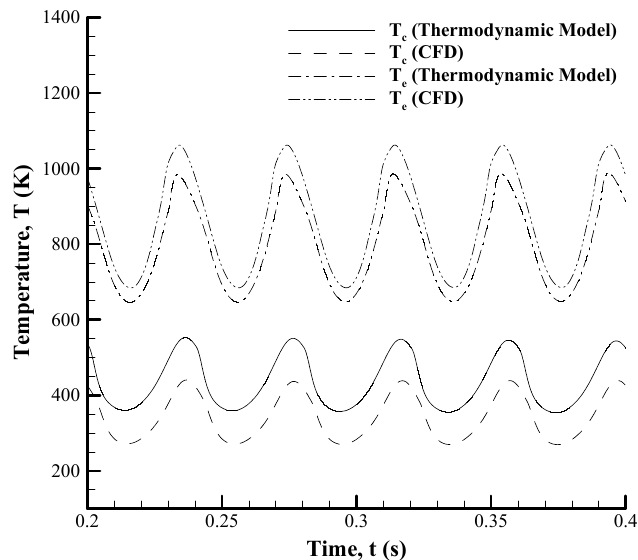
Figure 7. Comparison in expansion and compression chambers’ temperature variations. Table 3. Consumed computation time by thermodynamic and CFD